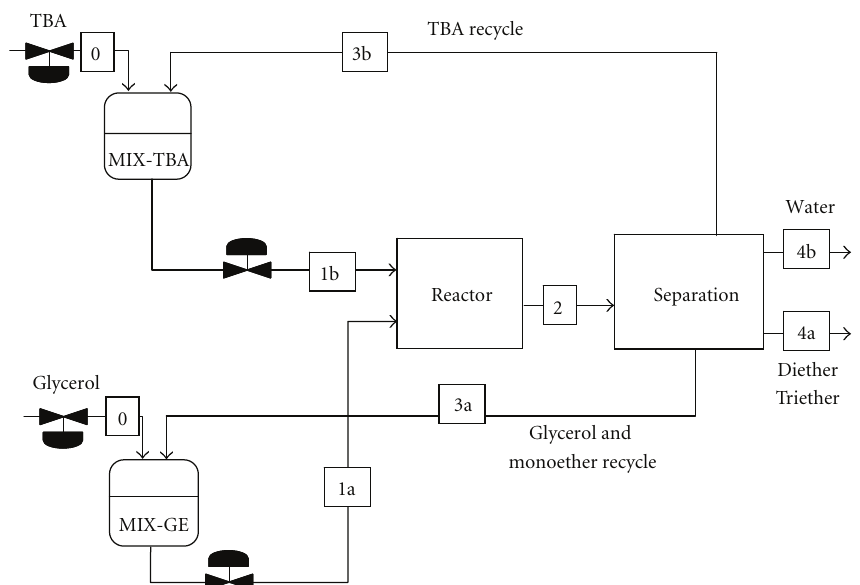
Figure 1: Reactor-separation-recycle structure of the glycerol-TBA etherification